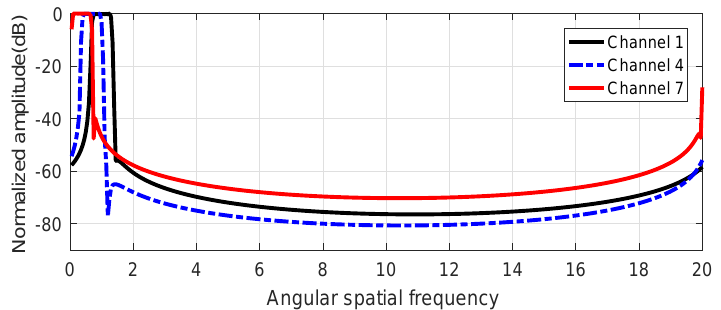
Figure 6. Angular spectrum of antenna